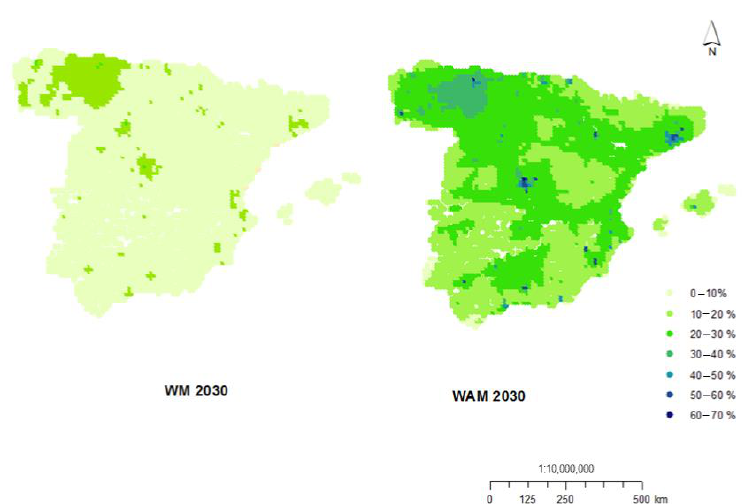
Figure 5. Spatial distribution of reduction of premature deaths in terms of percentage of avoided deaths, with respect to the reference scenario (2016), for the scenarios WM2030 ( left ) and WAM2030 ( right ).